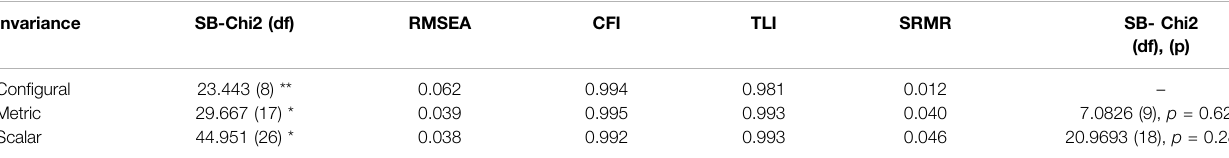
TABLE 1 | Measurement invariance test for CFA (1) for “ life satisfaction ” with four items across ethnic minority groups and generations ( N (cid:1) 2012). Invariance SB-Chi2 (df) RMSEA